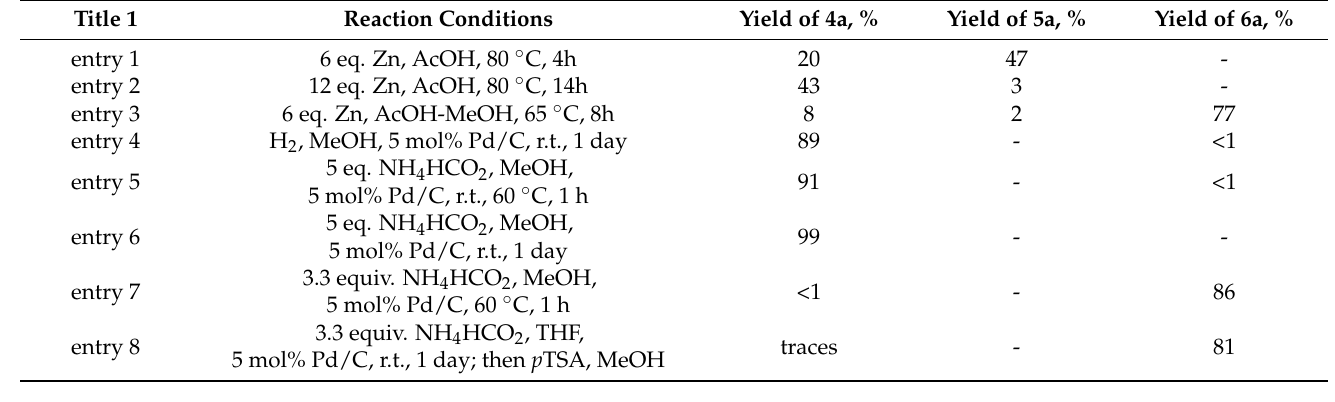
Table 1. Reduction of ketone 3a in various